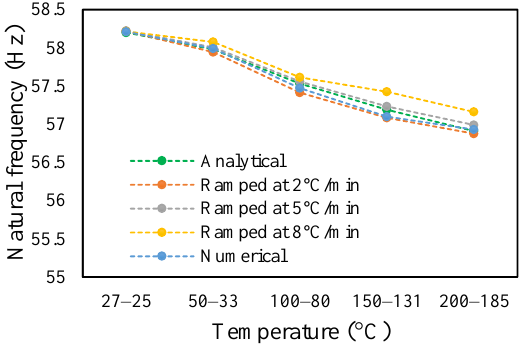
Figure 11. Natural frequency of healthy specimen in non-uniform temperature.